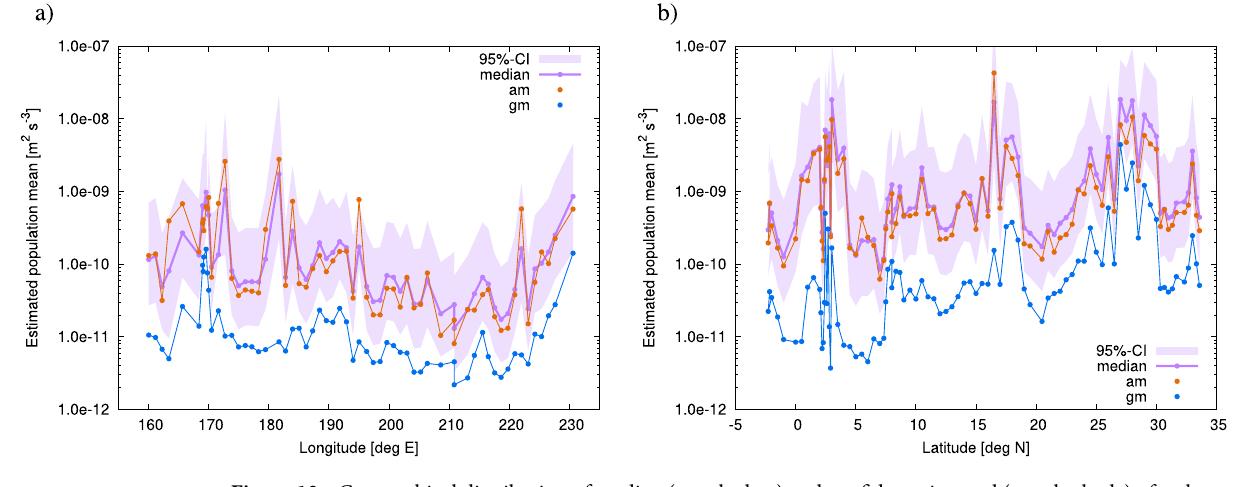
Figure 13. Geographical distribution of median (purple dots) and confidence interval (purple shade) of ǫ along ( a ) 47 ◦ N and ( b ) 137 ◦ E . The horizontal axis shows the location. Arithmetic mean (orange) and geometric mean (blue) are also shown.